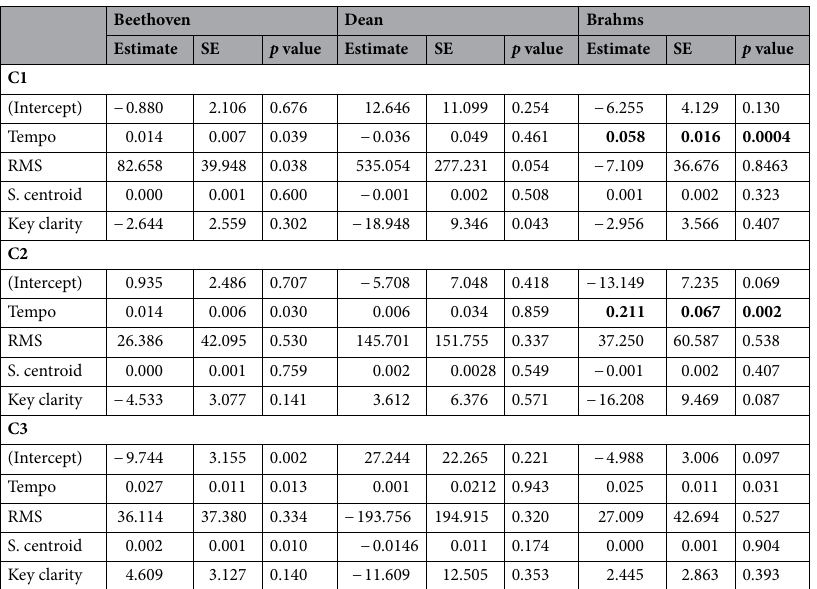
Table 4. Logistic regressions for combined respiration rate and skin conductance response synchrony per piece across all concerts. Synchrony (HS = 1, LS = 0) was the dependent variable, and tempo, key clarity, loudness, and spectral centroid (s. centroid) from the HS and LS bars as continuous predictors. The Bonferroni-corrected critical p value is 0.05/27 = 0.0019. Values highlighted in bold are statistically significant after Bonferroni corrections for multiple